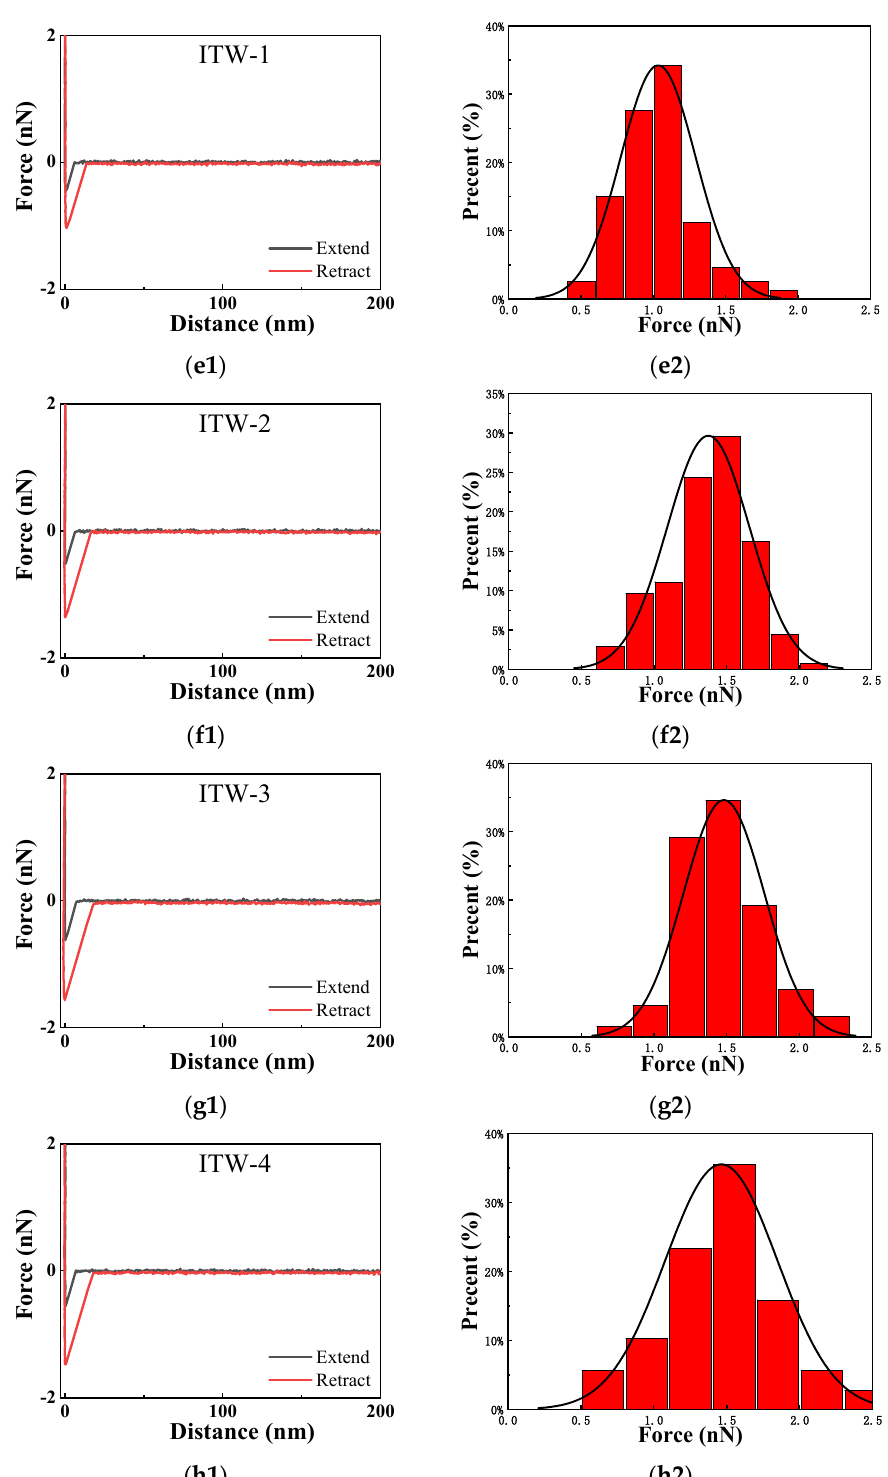
Figure 4. Approach and retraction force curves, as well as histograms of adhesion forces, as a function of separation between the C5Pe ‐ modified AFM tip and calcite surfaces in different brines. ( a1 , a2 ): FW; ( b1 , b2 ) : SW; ( c1 , c2 ): 10d SW; ( d1 , d2 ): 20d SW; ( e1 , e2 ): ITW ‐ 1; ( f1 , f2 ): ITW ‐ 2; ( g1 , g2 ): ITW ‐ 3; ( h1 , h2 ): ITW ‐ 4).